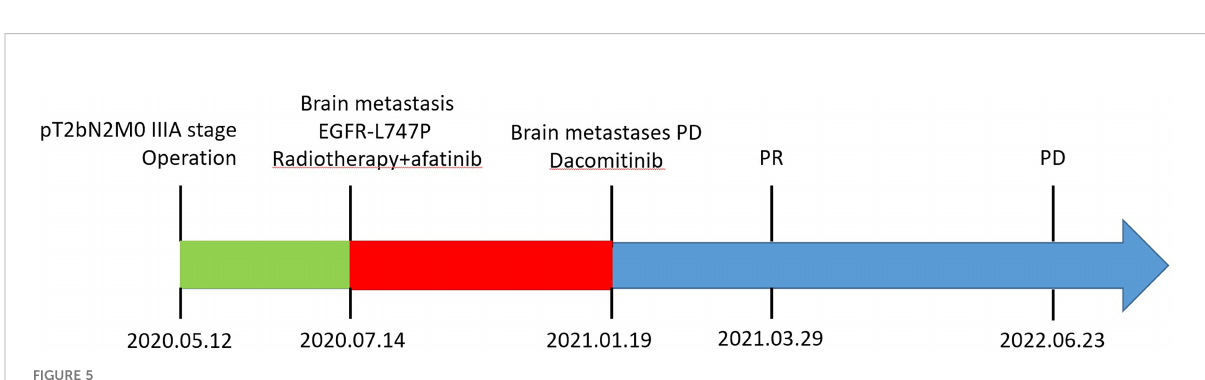
FIGURE 5 Treatment history and genomic results during the patient ’ s clinical